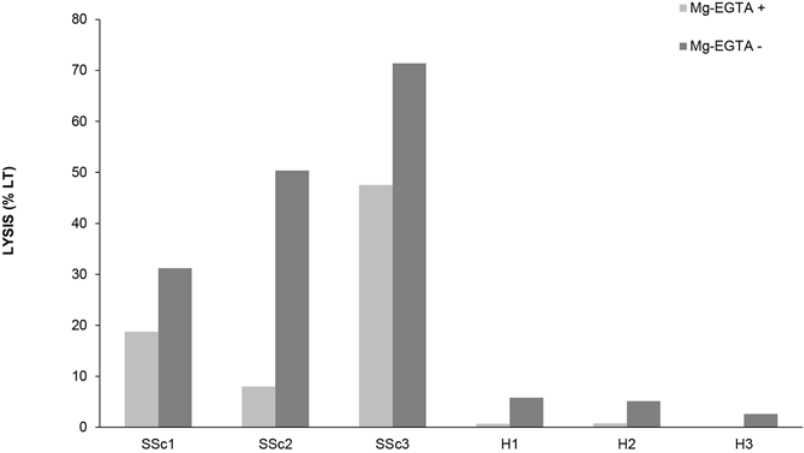
Fig 1. Serum hemolytic activity is increased in SSc patients. Sera from three different SSc patients (SSc1-SSc3) and three different healthy subjects (H1 – H3) were tested both in the presence and absence of Mg-EGTA. Mg-EGTA was used to block the classical and lectin pathways of complement. Data are expressed as percentage of full RBC